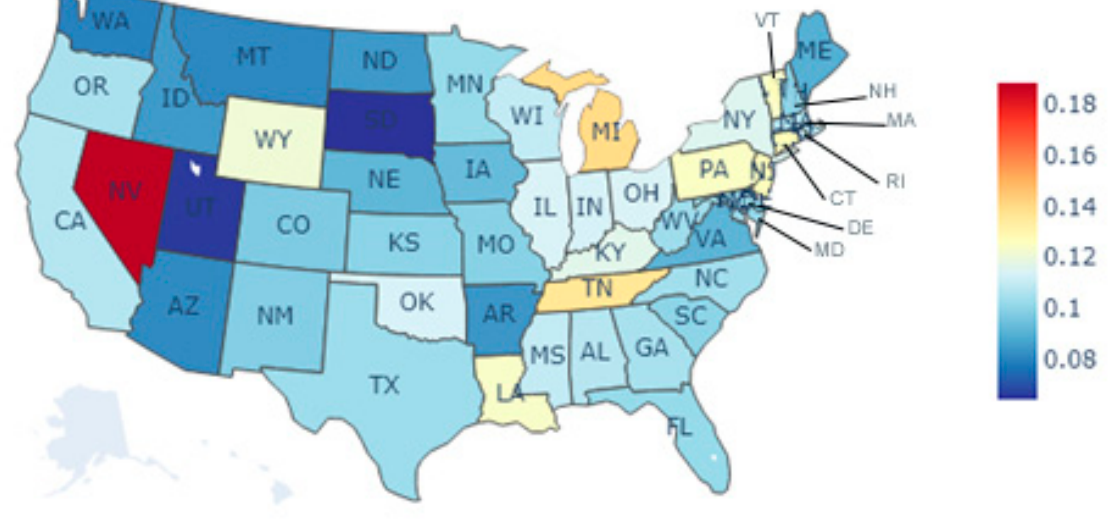
Figure 4. The maximum loss of the quarterly GDP in the pandemic 2020 and 2021 years as a fraction of the pre-pandemic GDP level in the 4th quarter of 2019.